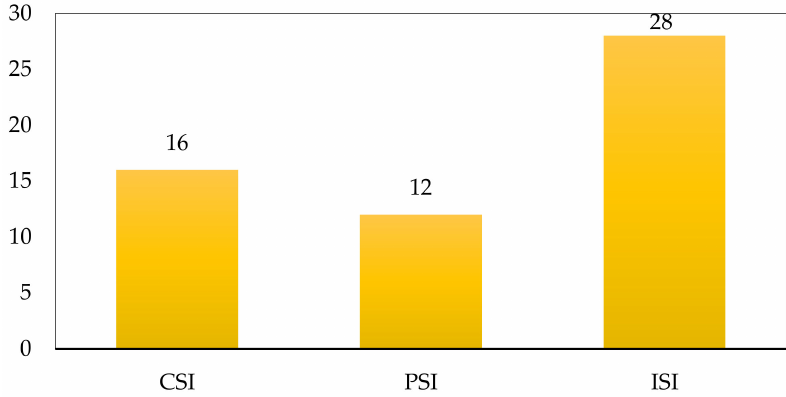
Figure 4. Contribution of chemical and process Inherent Safety Index (ISI)